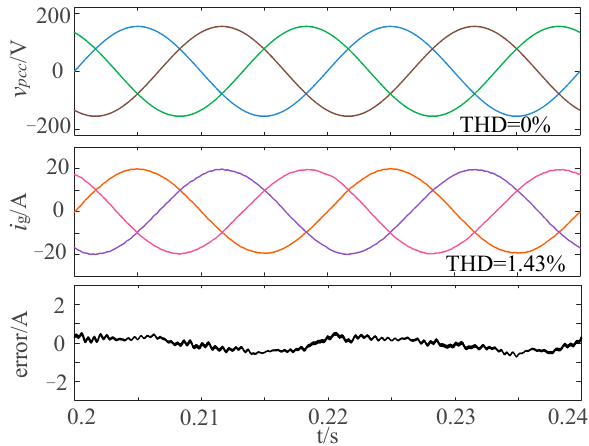
Figure 11. Steady ‐ state responses when Lg is 0 mH. Figure 11. Steady-state responses when Lg is 0 mH.